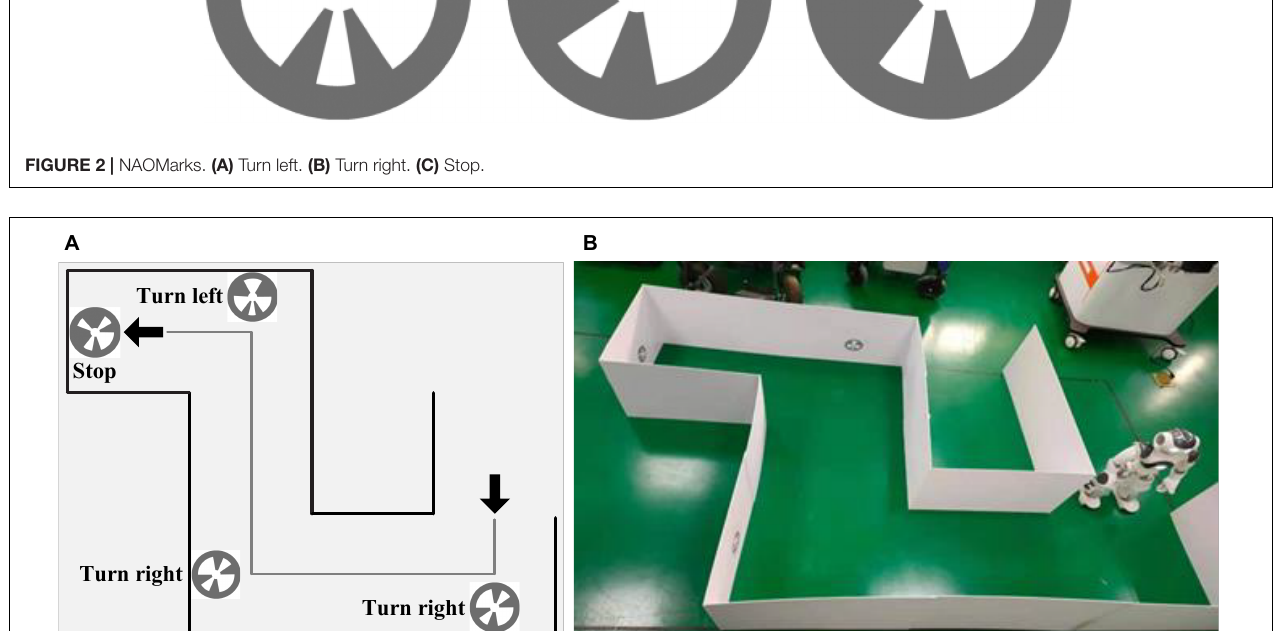
FIGURE 3 | The experimental scene. (A) Spatial distribution of the maze. (B) Experimental environment.